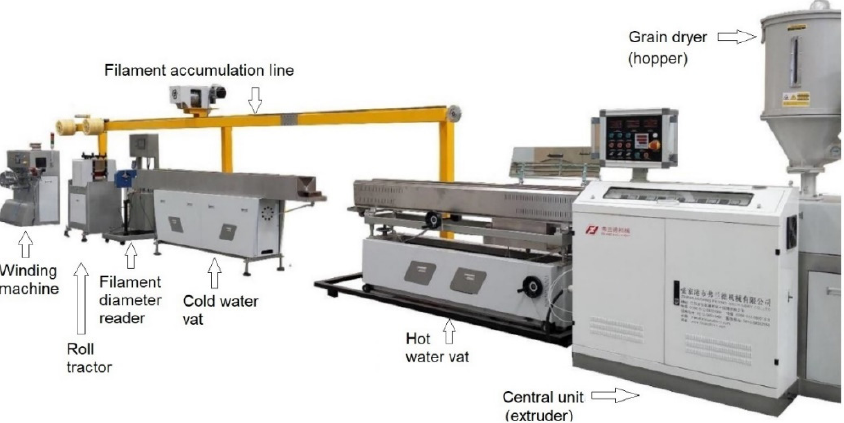
Figure 1. The experimental line for filament production from R-PET grains. After water removal in the grain dryer, the grains fell into the central unit, where they were heated up to 270 ◦ C. Then, they were extruded through a dye into a 1.75 mm-diameter filament which passed through the hot water (80 ◦ C) vat and the cold water vat, being drawn by the roll tractor. The rotation speed of the roll tractor was controlled by a laser system that read the filament’s diameter. Since the process was entirely continuous, before being wound into rolls, the filament was deviated by means of an accumulation line. Using R-PET filament, parallelepipedal specimens were printed with the dimensions 1 × 4 × 50 mm. Five different angles between specimens’ longitudinal axis and